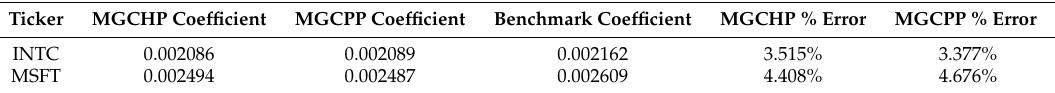
Table 6. Coefficients calculated by MGCHP and MGCPP models. Benchmark coefficients are coefficients of the least-square regression curves. Percentage errors are differences between two stochastic models with the